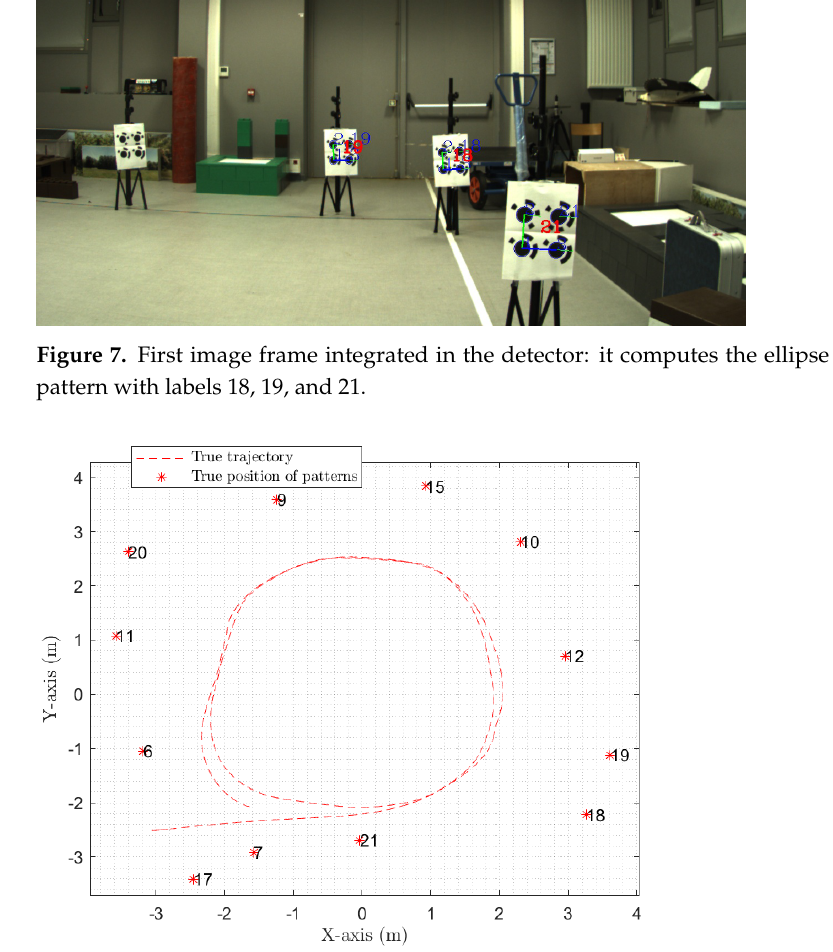
Figure 8. Ground truth obtained by an Optitrack motion capture system in the XY–plane, superim- posed to the position of the center of the bottom-left ellipse of each coded